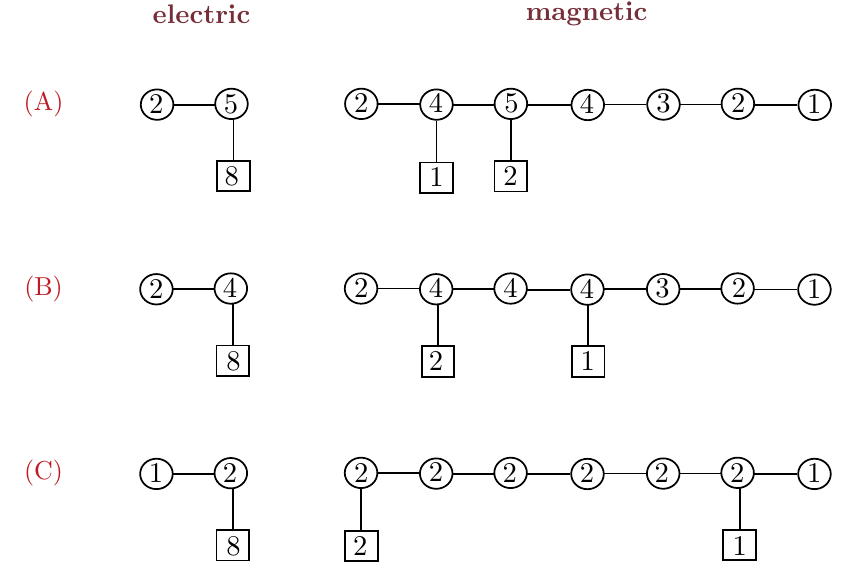
Figure 2 . The electric and magnetic quivers corresponding to the theories ( A; B; C ) of section 2. The infrared limits of these theories have the same (cid:13)avor symmetry but di(cid:11)erent operator